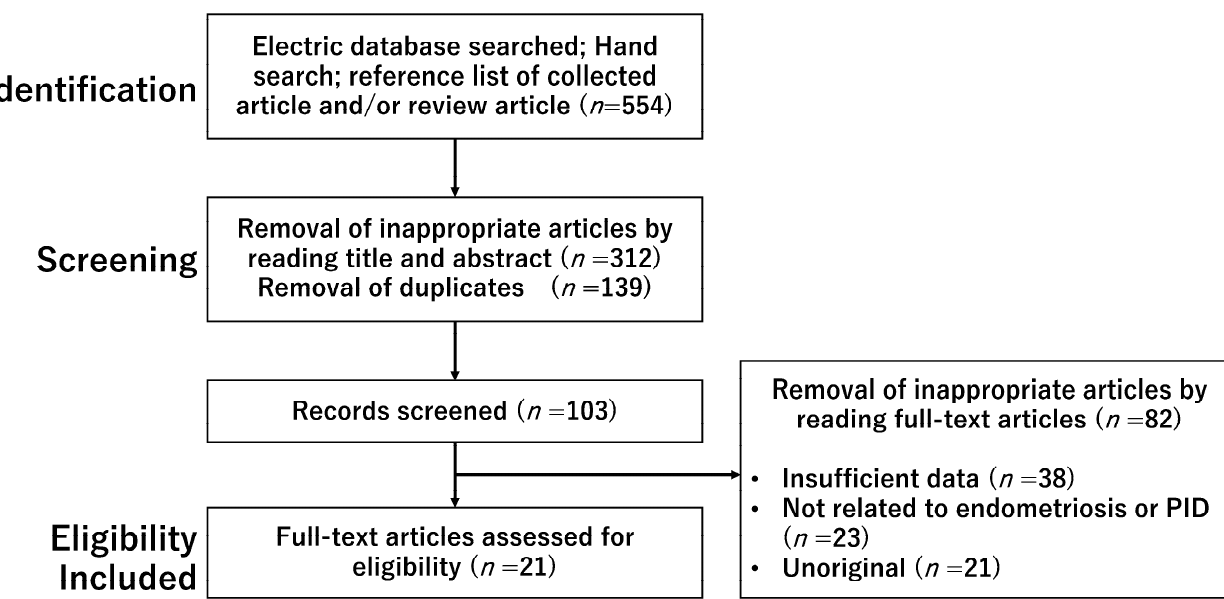
Figure 1. The number of articles identified by searching for keyword